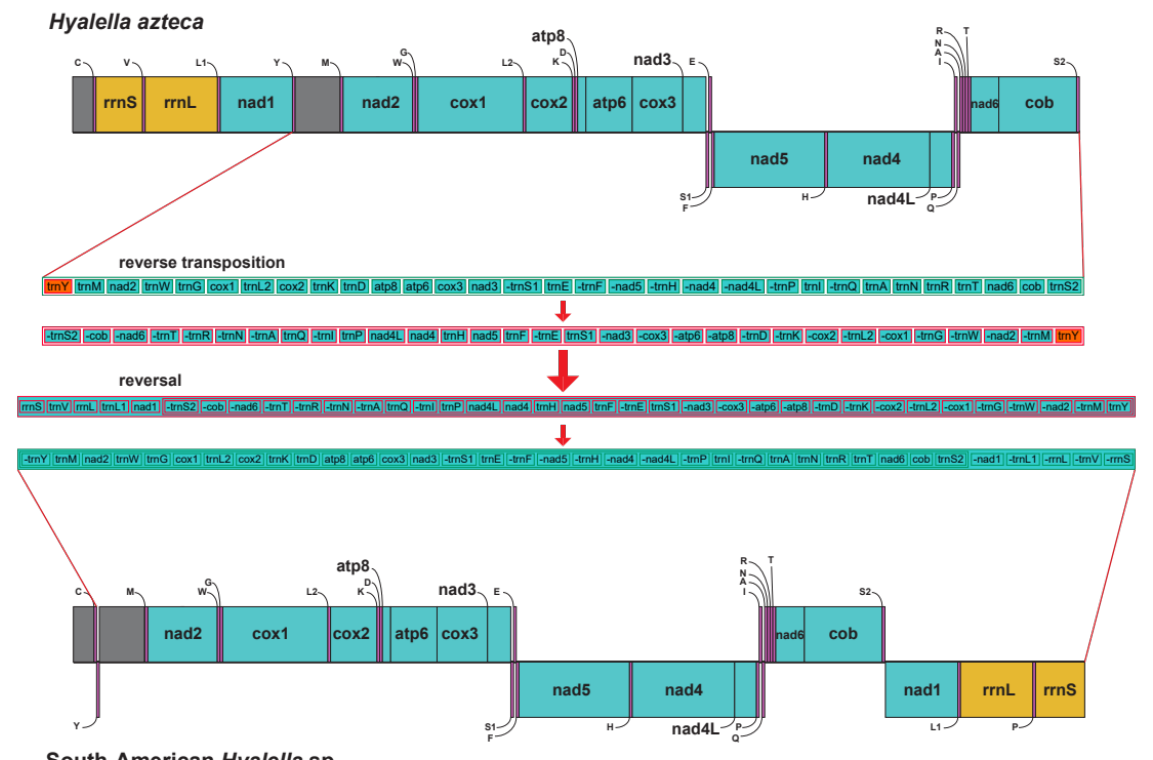
Figure 2. Hyalella mitochondrial genome maps. Gene order comparison between the mitogenomes of South American Hyalella species and the North American H. azteca . Genes located above the central line correspond to genes coded on the plus-strand, whereas those coded on the minus-strand appear below. Blocks in grey correspond to non-coding segments attributed to control regions. Shifts accounting for the observed differences between the two genome arrangements obtained with CREx are shown, with steps symbolized by arrows.